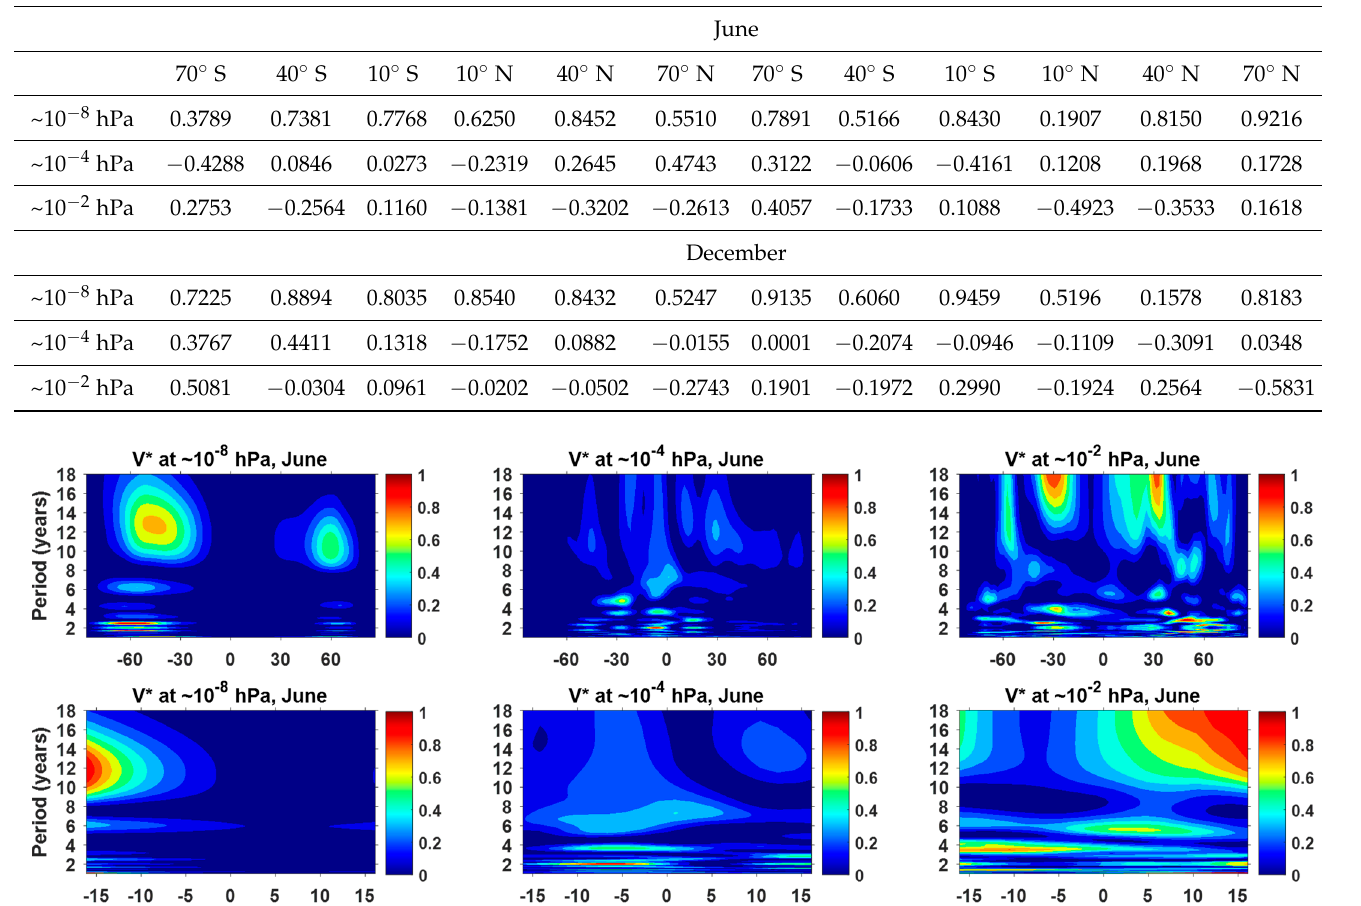
Figure 10. Time series of the meridional and vertical components of atmospheric circulation at a specified altitude (~10 − 8 hPa, first two rows; ~10 − 4 hPa, middle two rows; ~10 − 2 hPa, last two rows) and latitude (~70° S, left column; ~40° S, middle column; ~10° S, right column) and the F10.7 solar index in December from 2002 to 2019. The black and red lines indicate the F10.7 solar index and the corresponding component of atmospheric circulation, respectively. Table 1. Correlation coefficients of the meridional (V*) and vertical (W*) components of the atmospheric circulation at a specified altitude and latitude with the F10.7 solar index in June and December from 2002 to 2019. V*